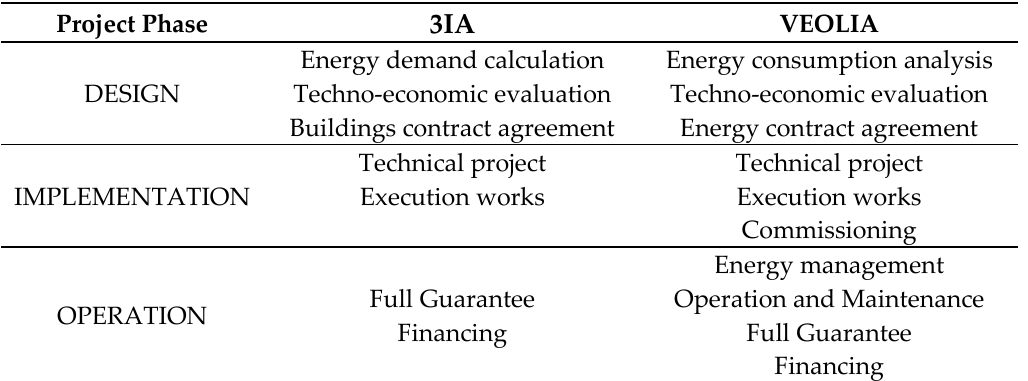
Table 2. Services provided in Torrelago